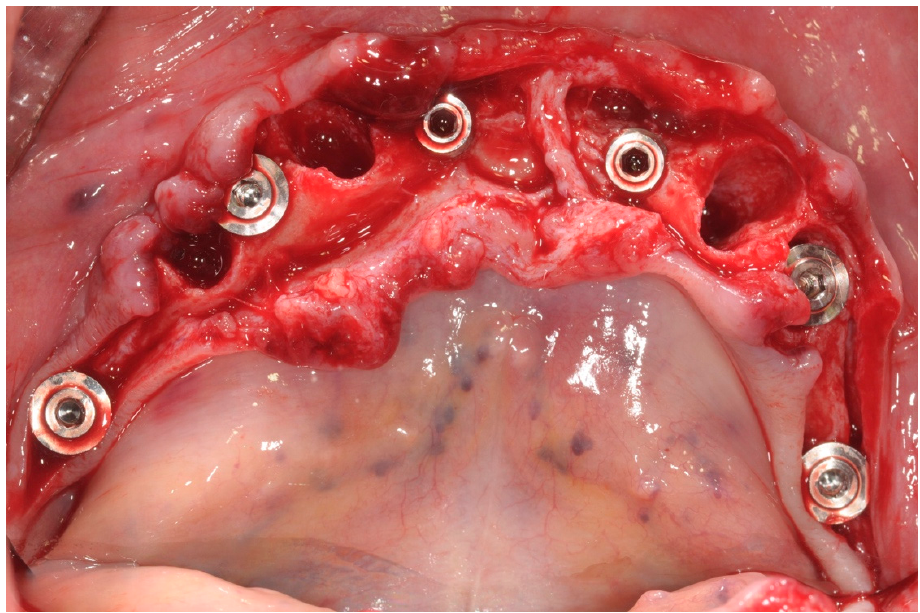
Figure 4. Flat abutment connection.